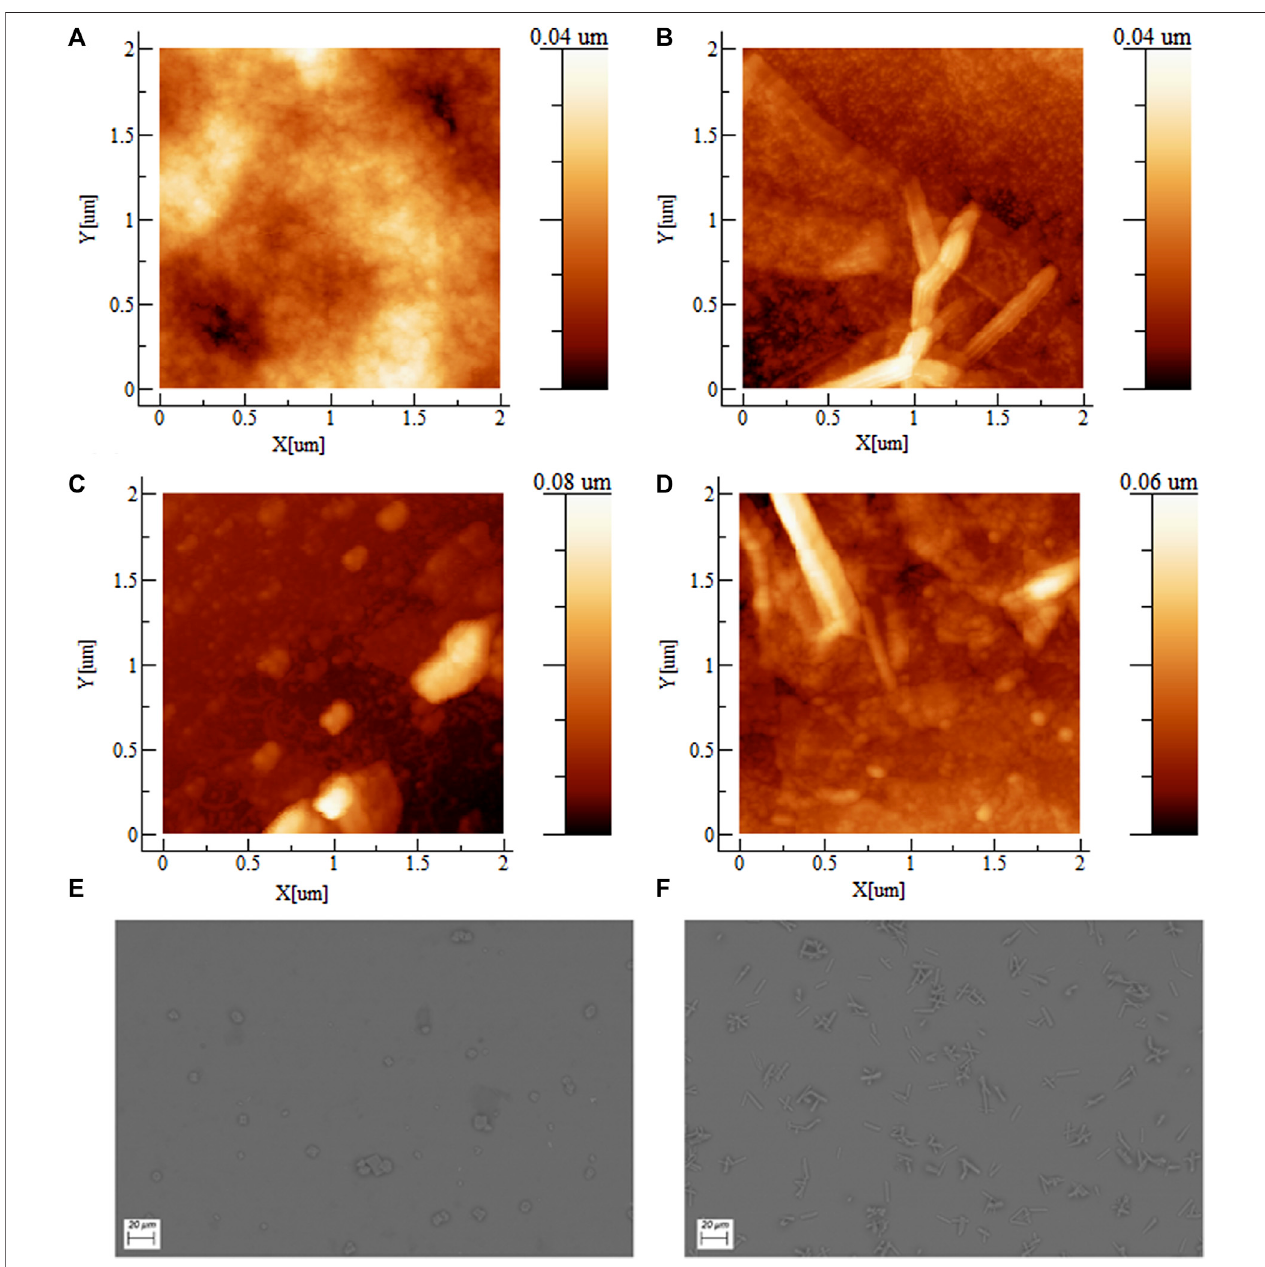
FIGURE 4 | AFM images of (A) PEDOT:PSS fi lm without graphene, (B) PEDOT:PSS-graphene, (C) PEDOT:PSS-graphene- a complex, and (D) PEDOT:PSS- graphene- b complex fi lms. SEM images of hybrid fi lms for (E) PEDOT:PSS-graphene- a complex and (F) PEDOT:PSS-graphene- b complex.